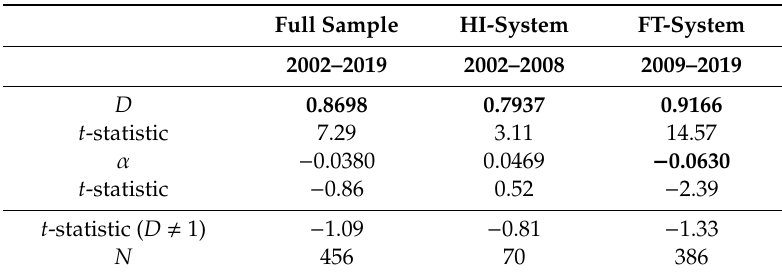
Table 2. Price-drop ratio on the ex-date.